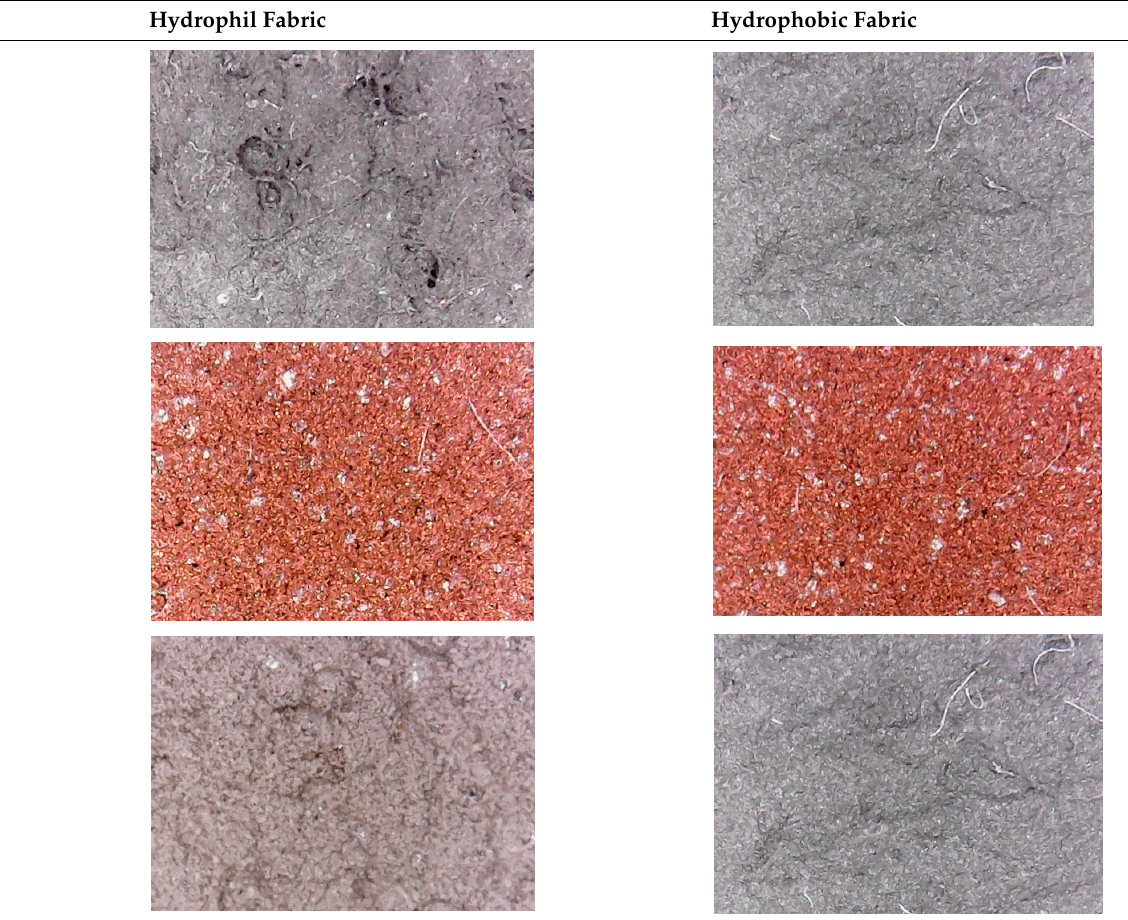
Table 4. Topography analysis of the samples obtained by classical technologies: boiling-bleaching (samples A1–A3) and alkaline boiling-bleaching followed by hydrophobization using NUVA TTC (samples A4–A6) and scraping of conductive pastes based on PVA matrix and Ni, Cu and Ag microparticles.